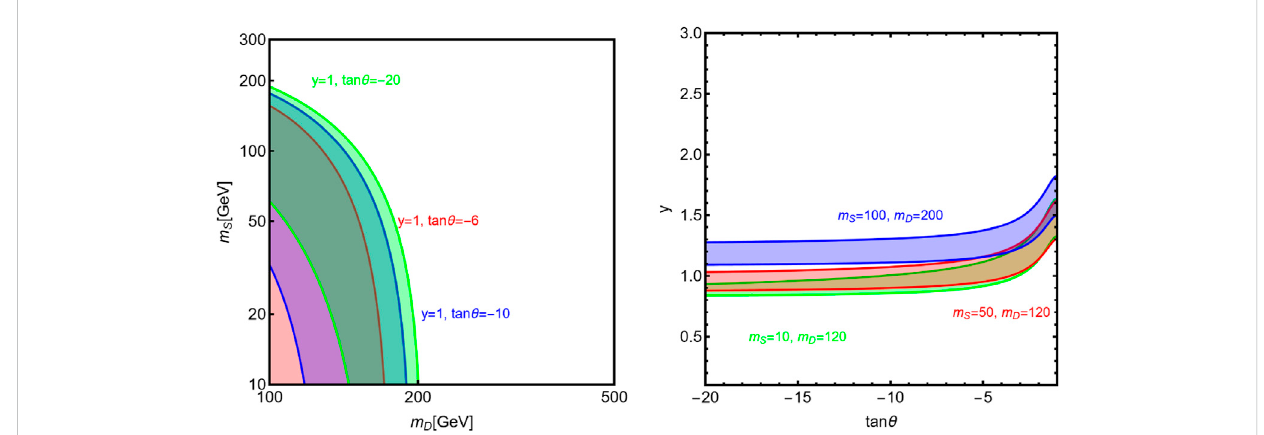
FIGURE 1 Regions of the [ m D , m S ] (left) and [tan θ , y ] (right) planes for the singlet – doublet model with an SM-like Higgs sector which comply with the M CDF W anomaly. The different colors correspond to the choices of ( y , tan θ ) or ( m S , m D ) given in the